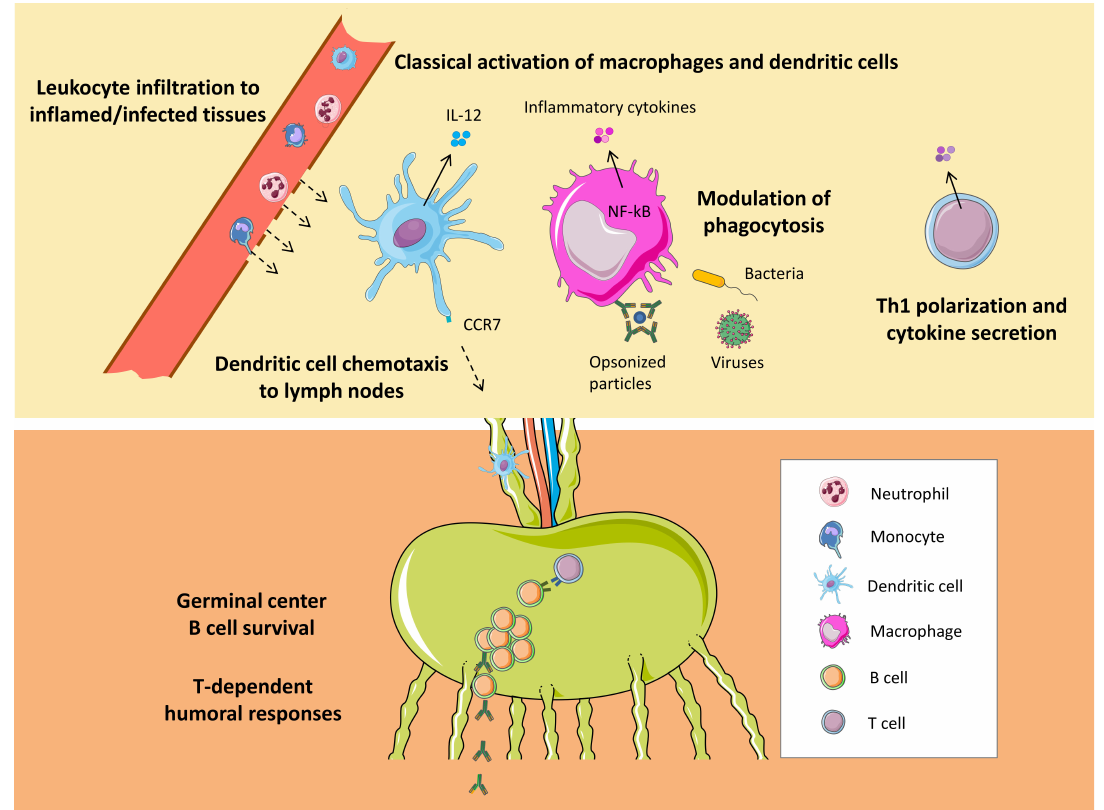
Figure 1. Summary of immunological roles of CD38 in the response to infection. Steps of the immune response to pathogens for which there are solid data involving the participation of CD38. Some elements in the image have been obtained from Smart Servier Medical